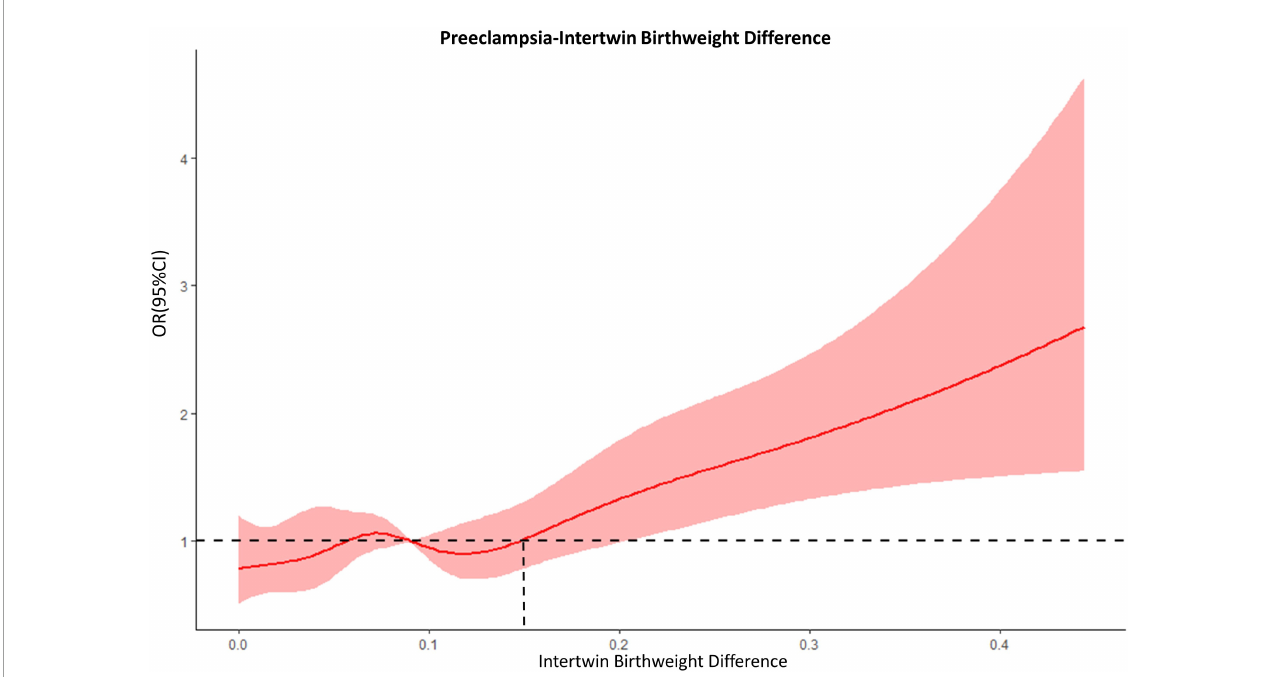
FIGURE1 The dose-response relationship between intertwin BWD and preeclampsia. Dashed lines, the reference line (OR = 1.0); red bands, 95% confidential intervals.